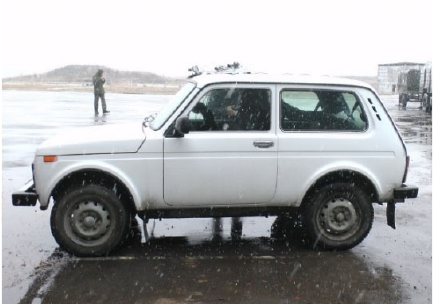
Figure 2 . Mono, stereo forward-looking and omnidirectional recording units installed on the roof of the Niva car.